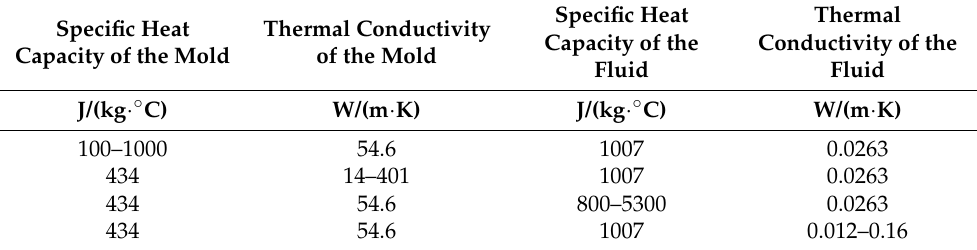
Table 3. Collected data of all numerical simulations. Specific